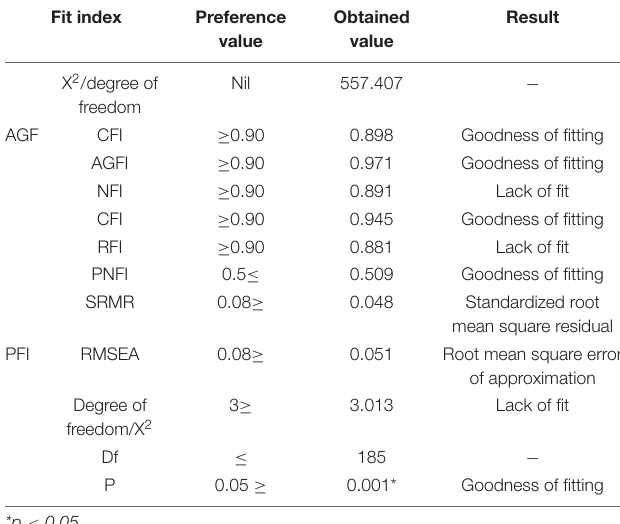
TABLE 10 | Goodness-of-fit indices of the research variables before revision.